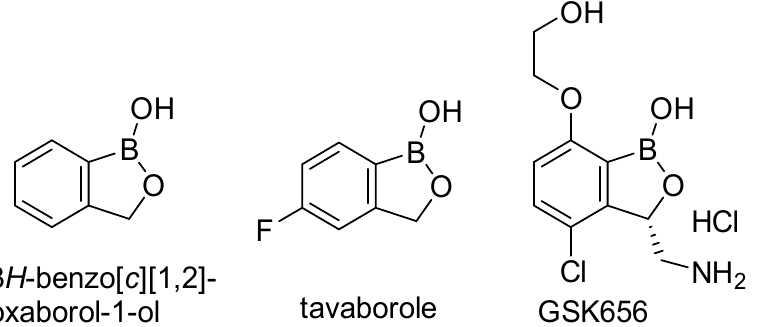
Figure 1. 3 H -benzo[ c ][1,2]oxaborol-1-ol and its important derivatives with antimicrobial activity. Figure 1. 3 H ‐ benzo[ c ][1,2]oxaborol ‐ 1 ‐ ol and its important derivatives with antimicrobial activity.